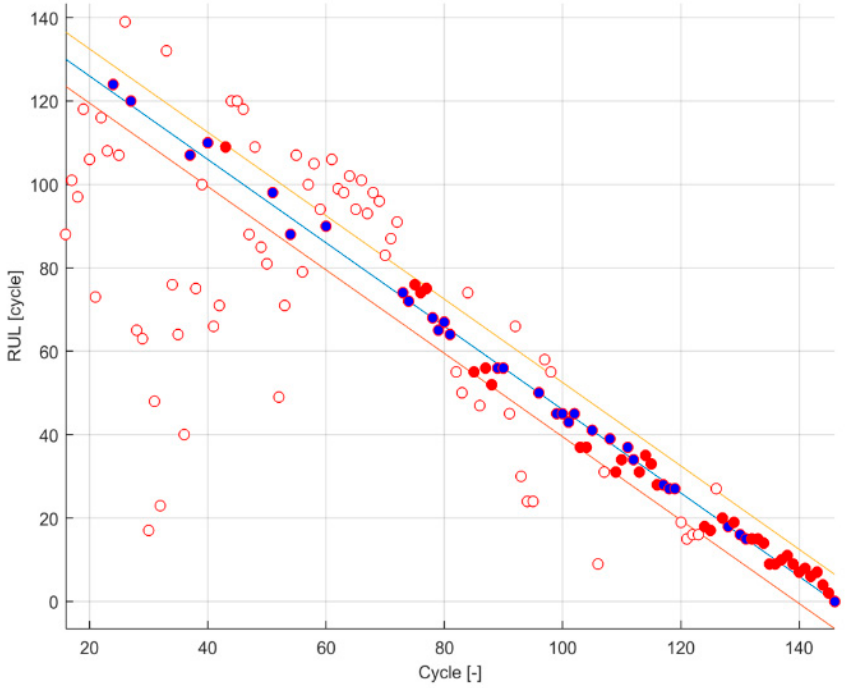
Figure 6. Results from test nº 2 (“B0018” linearly modelled).